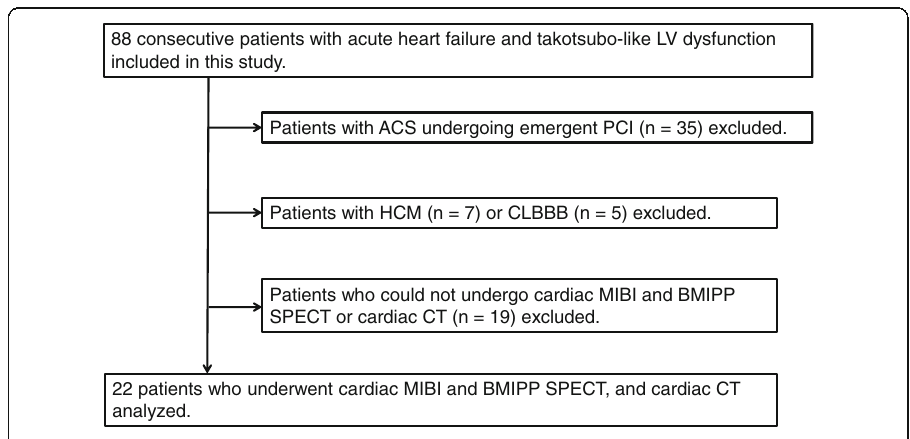
Fig. 1 Flow chart of patient inclusion and exclusion in this